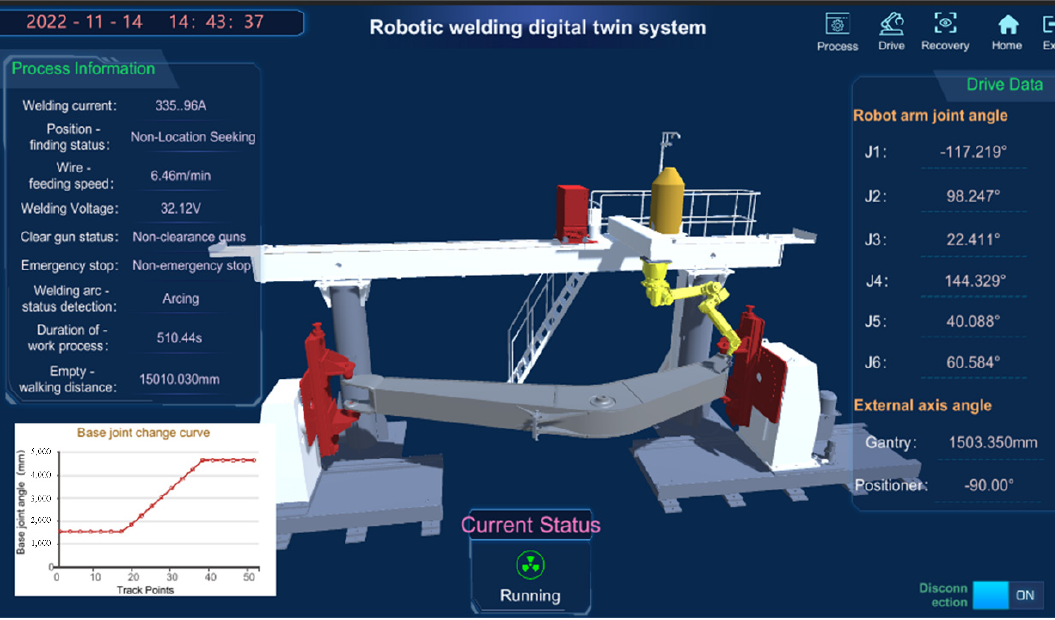
Figure 15. Experimental demonstration of welding twin process.